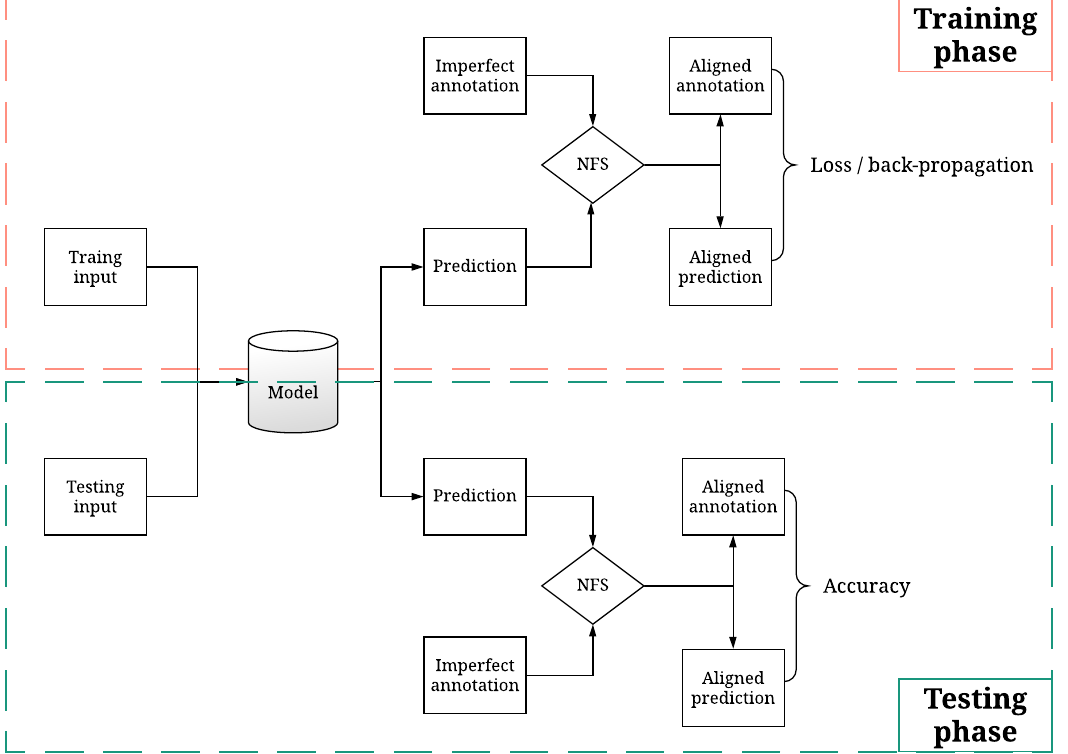
Figure 2. Experimental design for model training and evaluation under imperfect annotation. The proposed nearest feature selector(NFS) is applied to perform similarity selection during training and testing